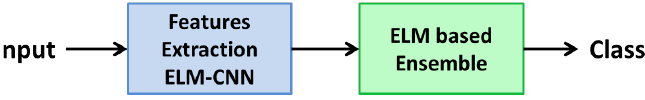
Figure 1. The proposed approach is built on two components: features extraction using the proposed Extreme Learning Machine based Convolutional Neural Network algorithm (ELM-CNN), and classification using the Extreme Learning Machine (ELM) based